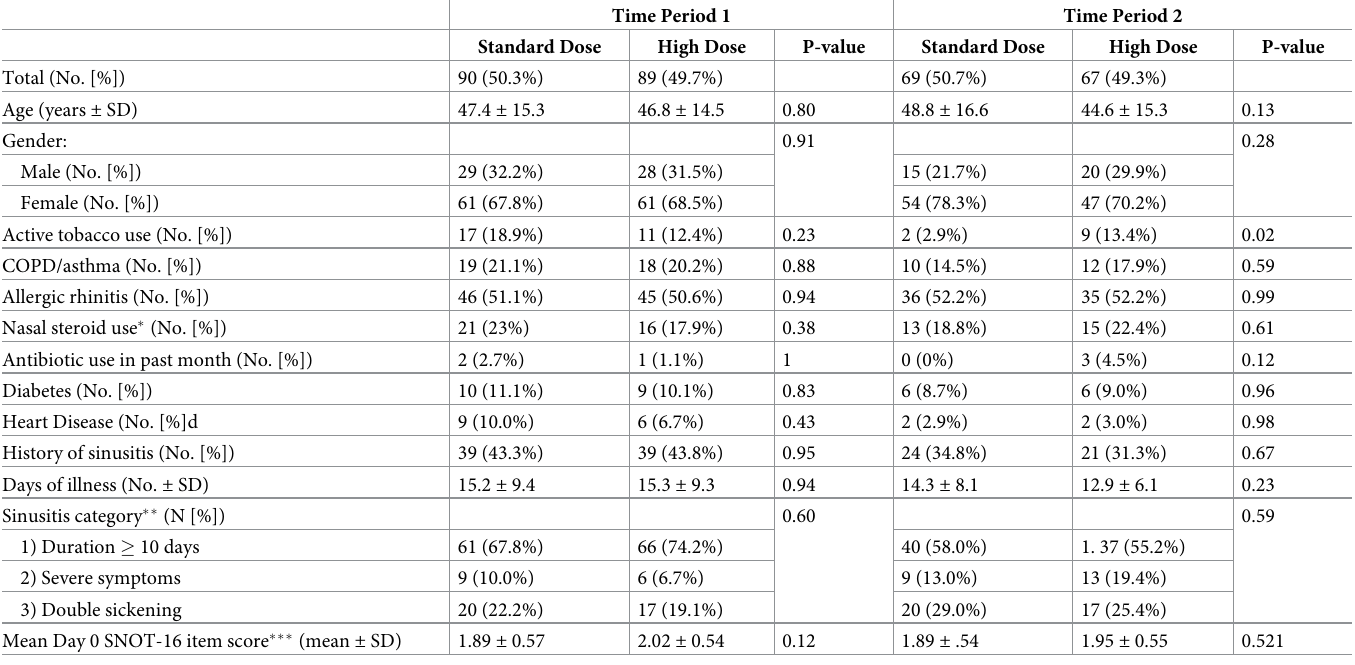
Table 3. Baseline characteristics by Time Period and